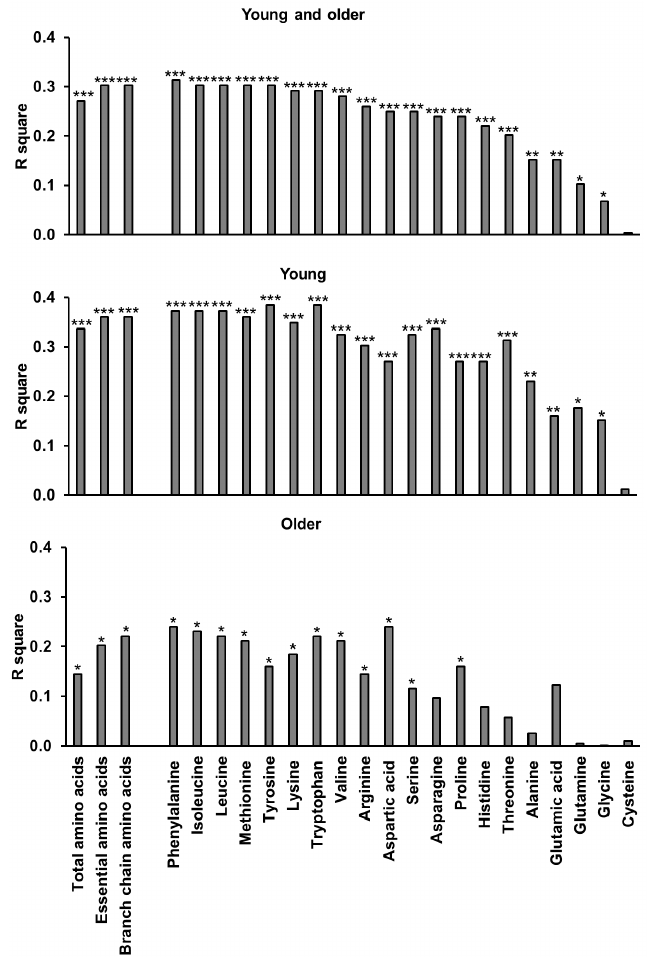
Figure A2. Within-subject relationships between energy intake [results of suppression of ad libitum energy intake after the intraduodenally infused whey-protein loads have been published previously [31]] and area under the curve (AUC 0–60 min) of total, essential amino acids (histidine, isoleucine, leucine, lysine, methionine, phenylalanine, threonine, tryptophan, and valine), branched chain amino acids (isoleucine, leucine, and valine), and individual amino acids in healthy older and younger men combined ( n = 20; n = 19 for histidine), younger men ( n = 10; n = 9 for histidine), and older men ( n = 10), ranked in order of the strongest to weakest R square in the combined group. Within-subject correlations were determined using a general linear model with fixed slope and random intercept. Statistical significance was accepted at p < 0.05.* p < 0.05, ** p < 0.005, *** p < 0.001.